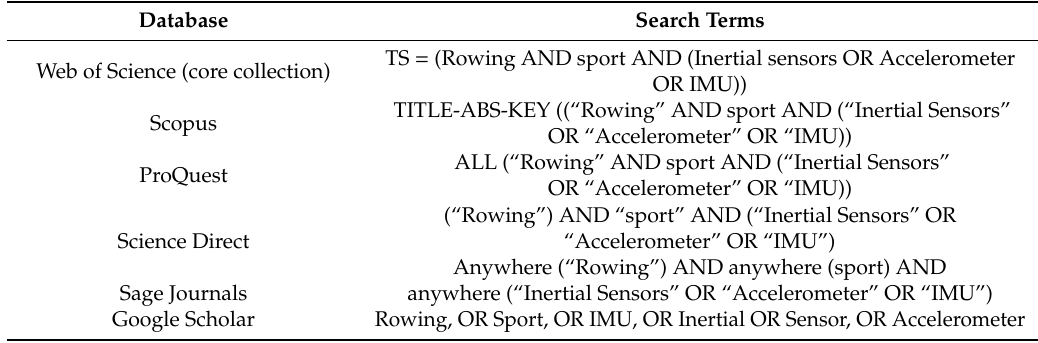
Table 1. Searched databases and associated search terms used, IMU (Inertial Measurement Unit).